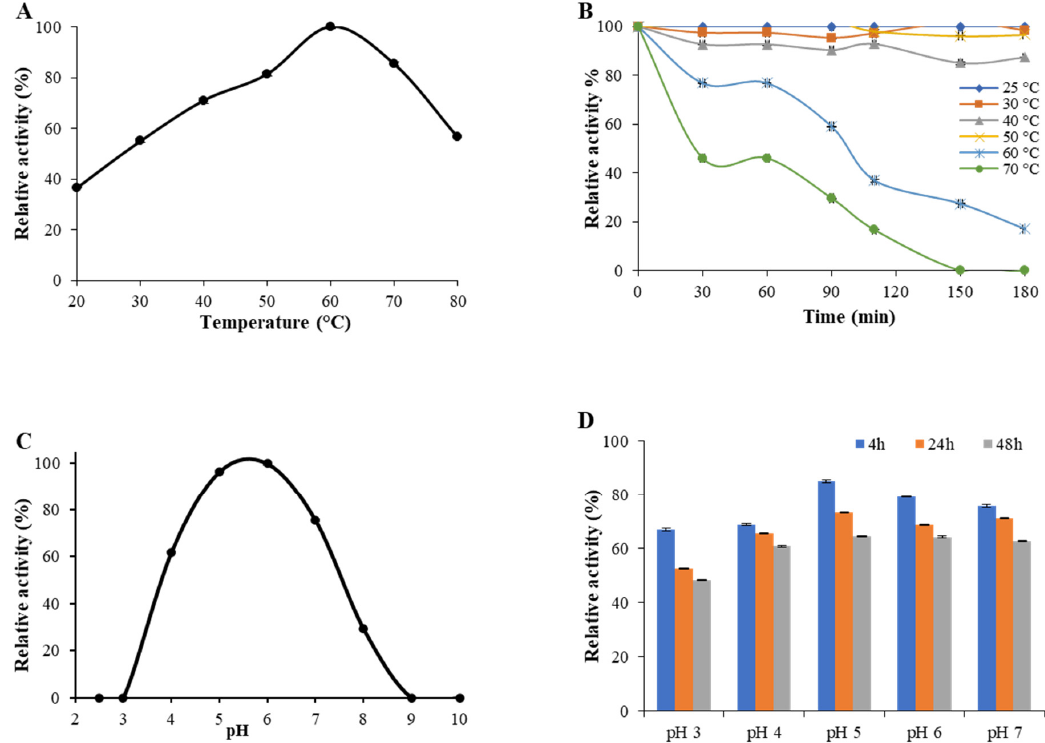
Figure 2. Enzyme activity and stability of Sl Lac2 at different pH and temperature. ( A ) The oxidation of syringaldazine (1 mM) was determined for the temperature curve in a sodium acetate buffer (50 mM, pH 6.0), and ( C ) for the pH curve at 30 °C. Values were calculated as a percentage of maximum activity (set at 100%) at optimum temperature and pH. ( B ) Residual activities were estimated after 30, 60, 90, 120, and 180 min of incubation at six different temperatures ranging from 25 to 70 °C or ( D ) after 4, 24, and 48 h at five different pH values ranging from 3.0 to 7.0. Residual activities are expressed as a percentage of the initial activity (point at time 0, measured immediately after adding the enzyme), which was set at 100%. Assays were performed using syringaldazine as a substrate in standard conditions. Each data point (mean +/ − standard deviation) is the result of triplicate experiments. 2.5. Effect of Metal Ions, Inhibitors and Solvents on Laccase Activity Various metal ions (Mo 2+ , Ag 2+ , AsO 43 − , Fe 2+ , Cd 2+ , Zn 2+ , and Cu 2+ ) at 10 mM concentration were tested on the activity of Sl Lac2 (Figure 3A). Mo 2+ and Ag 2+ caused the disappearance of 30% and 60% of Sl Lac2 activity, respectively. AsO 43 , Fe 2+ , Cd 2+ , and Zn 2+ led to an even greater decrease in laccase activity (about 90% inhibition), and Cu 2+ completely inhibited Sl Lac2 activity (98%).